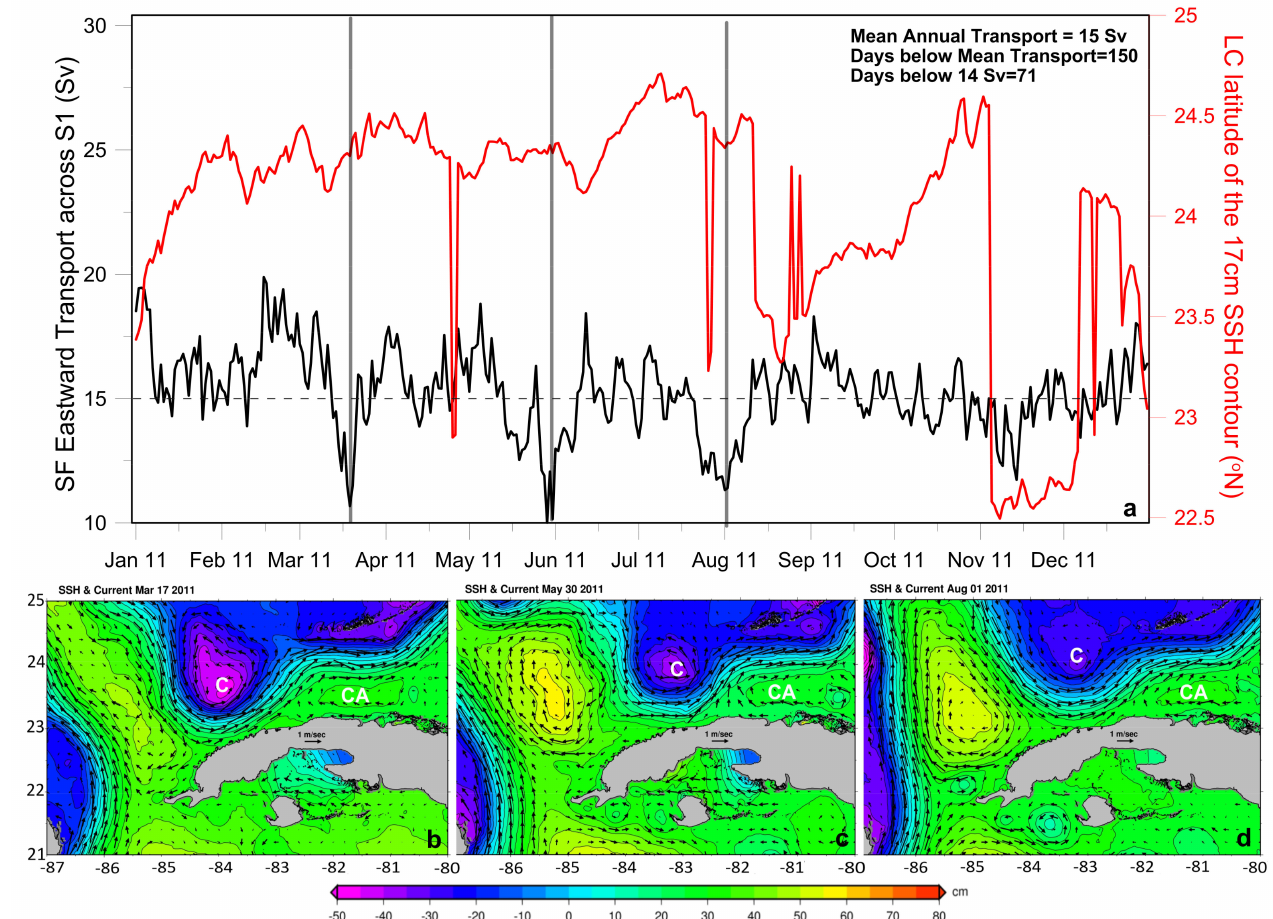
Figure 9. ( a ) Evolution of the integrated Straits of Florida (SF) eastward transport across section S1 (Figure 1; black line) and of the Loop Current (LC; 17 cm SSH contour) latitude (red line) during 2011, as derived from the GoM-HYCOM 1/50 model simulation. Maps of simulated sea surface height (SSH) and surface current vectors (m/s) over western Straits of Florida on ( b ) 17 March 2011, ( c ) 30 May 2011 and ( d ) 01 August 2011. The cyclonic (C) and anticyclonic (CA) eddies are marked. The presence of CubAN events presented in ( b – d ) is marked with grey vertical lines in ( a ). The horizontal dashed line in ( a ) indicates the mean annual transport in